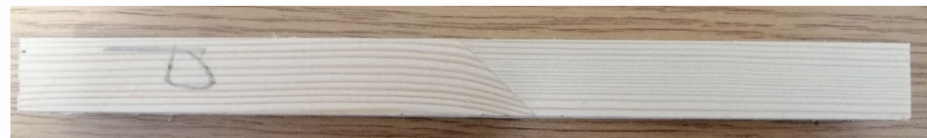
Figure 8. View of the tensile specimen (cross-section approx. 20 × 20